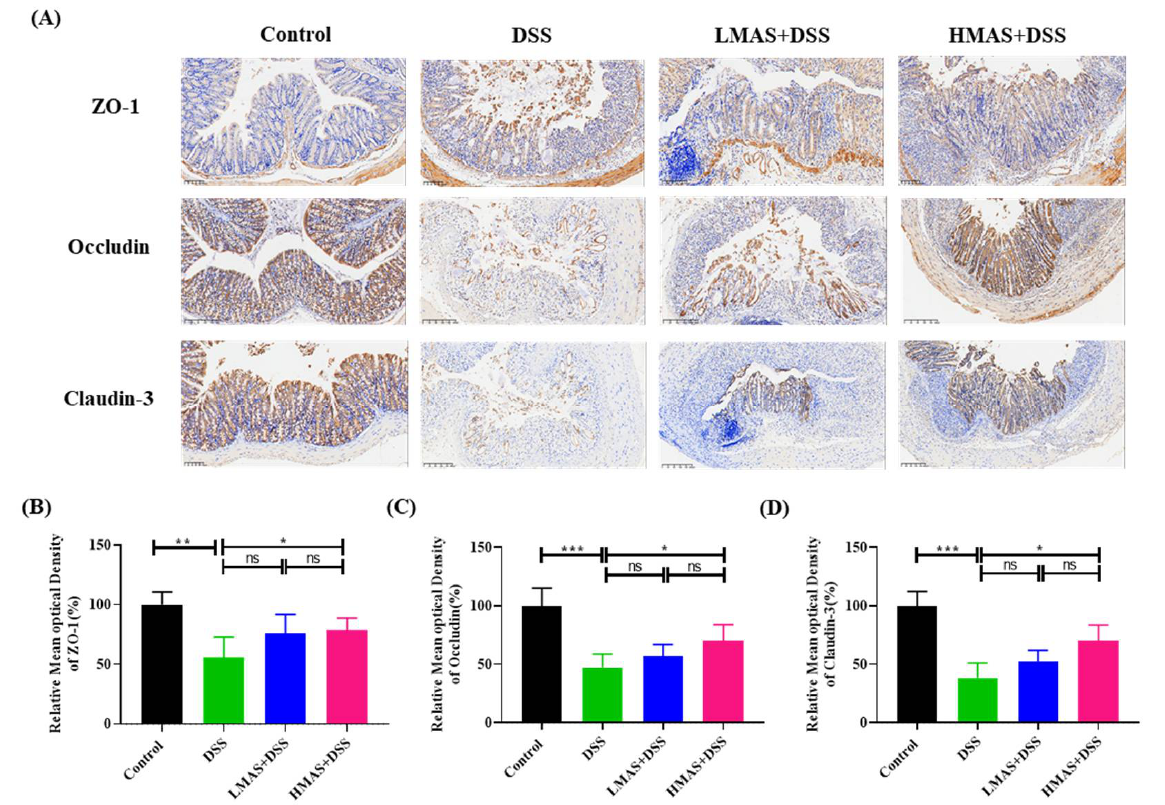
Figure 4. MAS reduced intestinal epithelial cell permeability in DSS-induced mice. ( A ) Immunohisto- chemistry analysis of ZO-1, Occludin, and Claudin-3; the image magnification is × 200. ( B – D ) Immunohistochemical analysis. Here, ns = not significant. Data are shown as the mean ± SD. * p < 0.05, ** p < 0.01, *** p < 0.001, in comparison with the DSS group (n = 10).